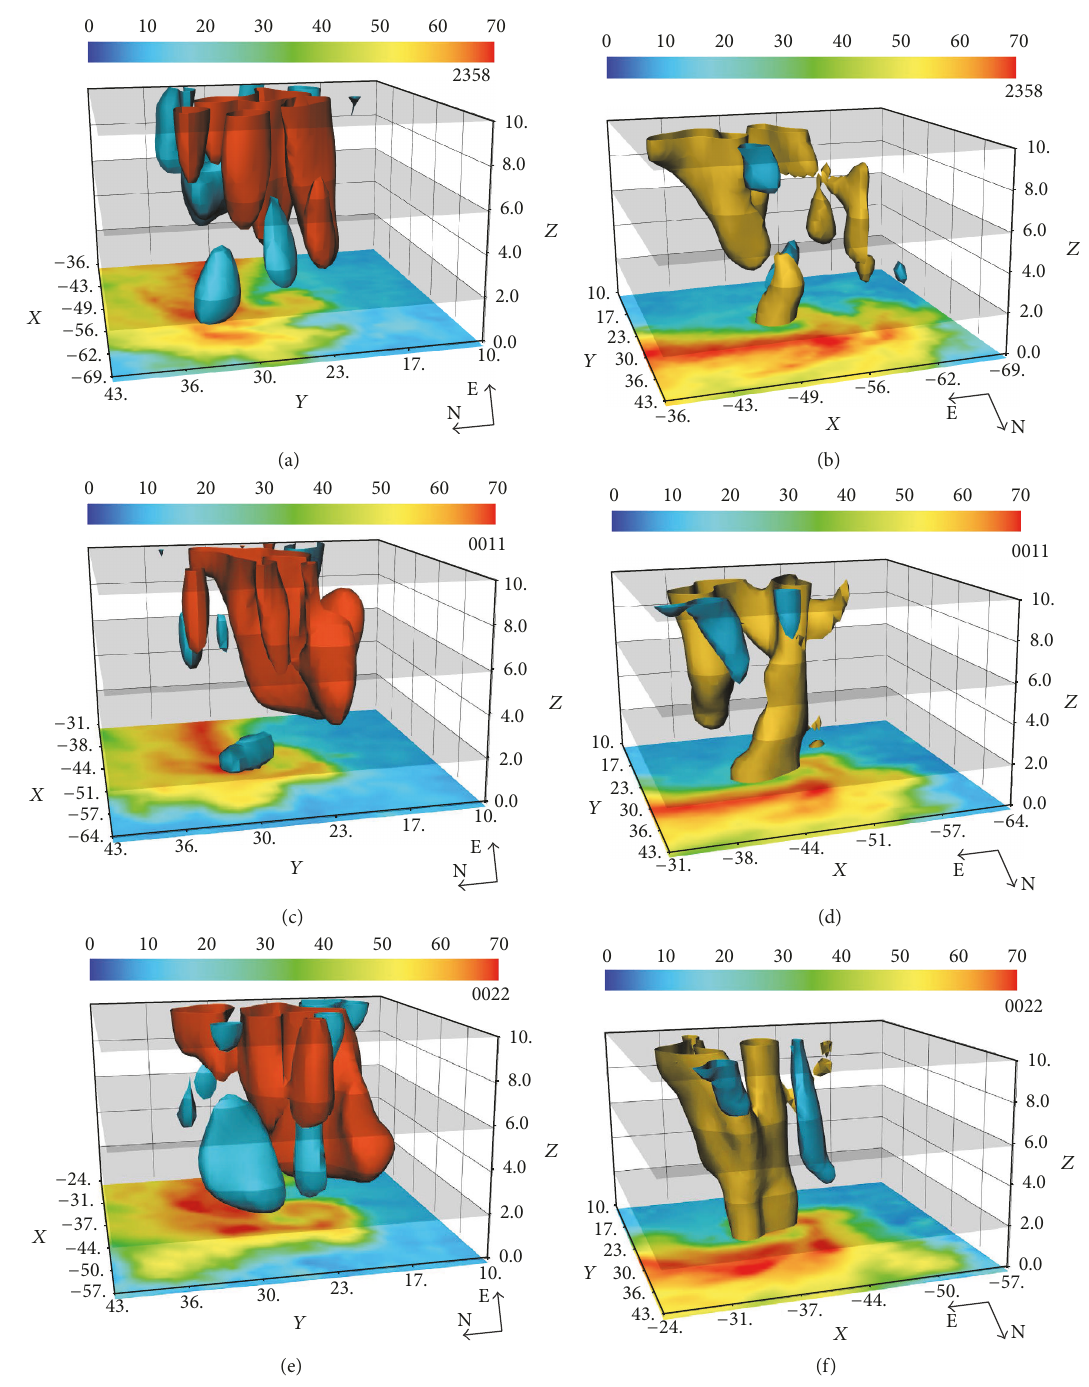
Figure 4: Three-dimensional isosurfaces of vertical velocity ( − 5ms −1 [blue] and 20 ms −1 [red], (a), (c), (e)) and vertical vorticity ( − 1 × 10 −3 s −1 [blue] and 1 × 10 −3 s −1 [gold], (b), (d), (f)) for 2358 UTC (a, b), 0011 UTC (c, d), and 0022 UTC (e, f). Radar reflectivity (in dBZ according to the color scale) at 1km altitude is plotted at the bottom of each panel. Horizontal planes at 2, 6, and 10km are shaded grey for reference. Note that panels (a), (c), and (e) are oriented with a perspective of looking at the storm from approximately the west while panels (b), (d), and (f) are oriented with a perspective of looking at the storm from approximately the